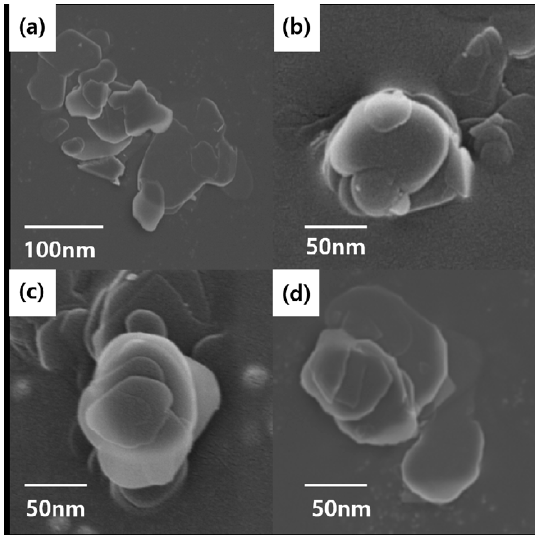
Figure 3. Field emission scanning electron microscope (FE-SEM) image of raw BN particles ( a ), and BN–OH particles ( b ).